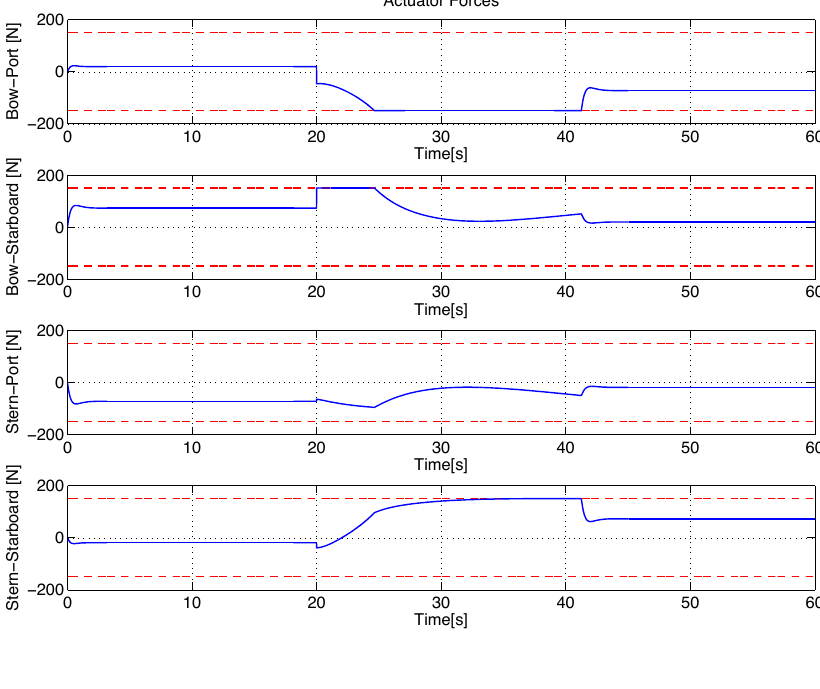
Figure 8: Actuator forces for a vehicle change in position while in